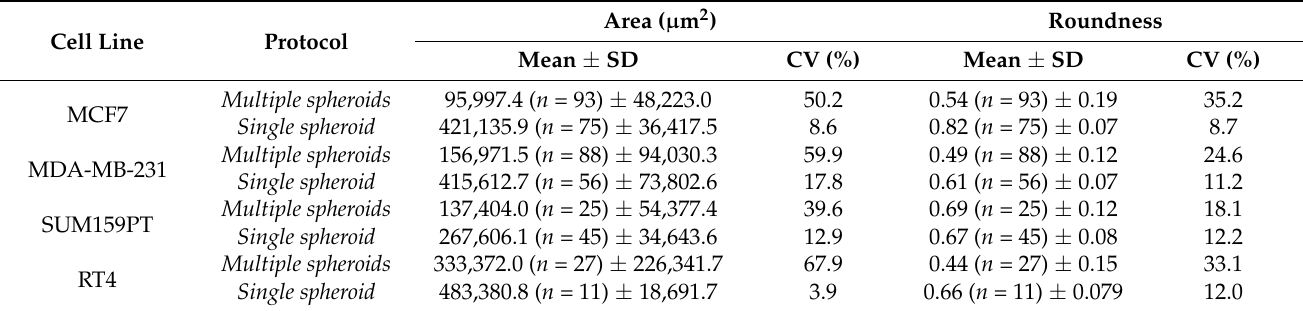
Table 1. Mean, standard deviation (SD), and Coefficient of Variation (CV) of Area and Roundness, measured on spheroids formed with the Multiple Spheroids Protocol and Single Spheroid Protocol in four cancer cell lines: MCF7, MDA-MB-231, SUM159PT, and